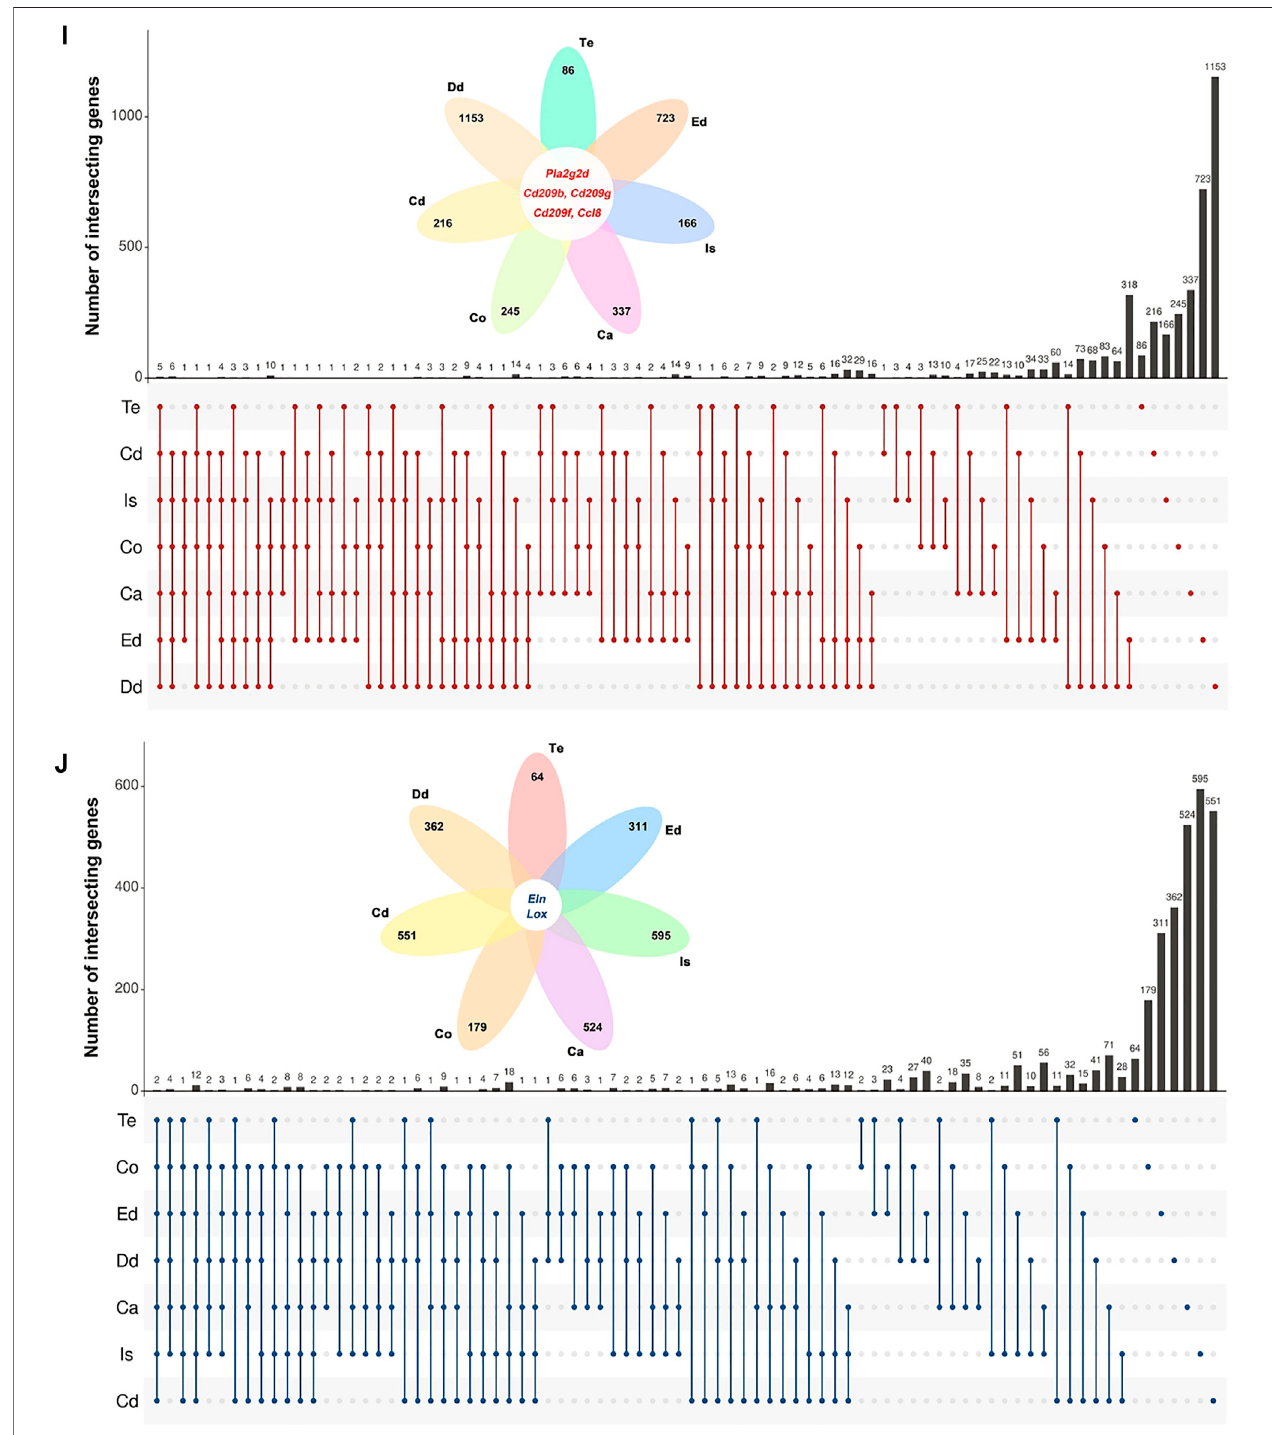
organs may undergo degenerative changes. In general, the functional analysis revealed increased immune response activities in the aging male reproductive